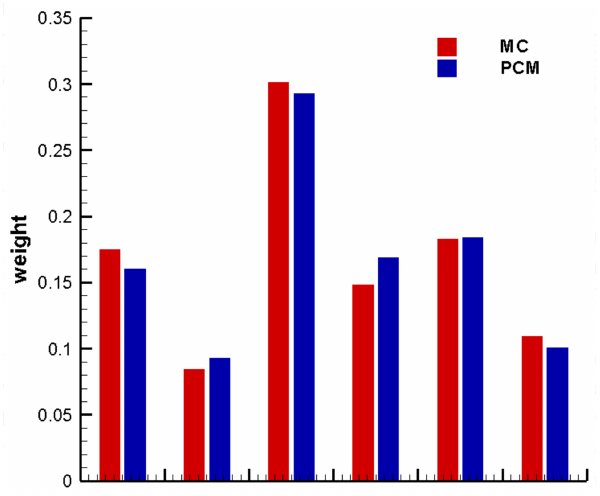
Figure 8. Comparison of posterior model weight for each postulated